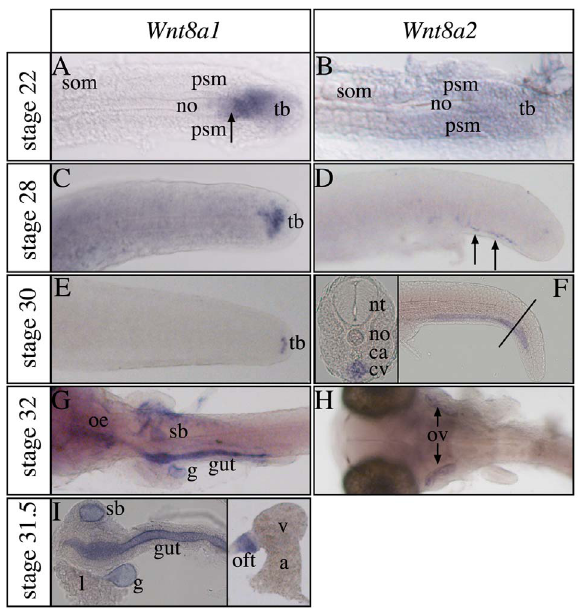
Figure 3. Wnt8a gene paralog expression pattern differ during somitogenesis and organogenesis. (A,B,E,G–I) Dorsal and (C,D,F) lateral views with anterior to the left, (A–F) focused on the tail region. (A,B) At 38 hours post fertilization (hpf), Wnt8a1 transcripts are found in the axial part of the tailbud including the posterior end of the notochord (arrow), while Wnt8a2 is widely expressed in the tailbud, presomitic mesoderm and developing somites. (C–F) Wnt8a1 express- ing cells are found in the tailbud at 2,5 days post fertilization (dpf) and 3,5 dpf and Wnt8a2 is expressed in caudal hematopoietic tissue (arrows in D). Line in (F) marks the position of the transversal section shown in the inset. (G) After 4 dpf, Wnt8a1 is expressed in the entire gut, oesophagus (not before 4 dpf (I)), swim- and gall bladder. The anatomy of these structures has been well described previously [40]. (I) The dissected gut system is shown for clarity. The inset shows Wnt8a1 expression in the outflow tract of the dissected heart. (H) Wnt8a2 transcripts are present in the otic vesicles. a, atrium; ca, caudal artery; cv, caudal vein; g, gall bladder; l, liver; no, notochord; nt, neural tube; oe, oesophagus; oft, outflow tract; ov, otic vesicle; psm,